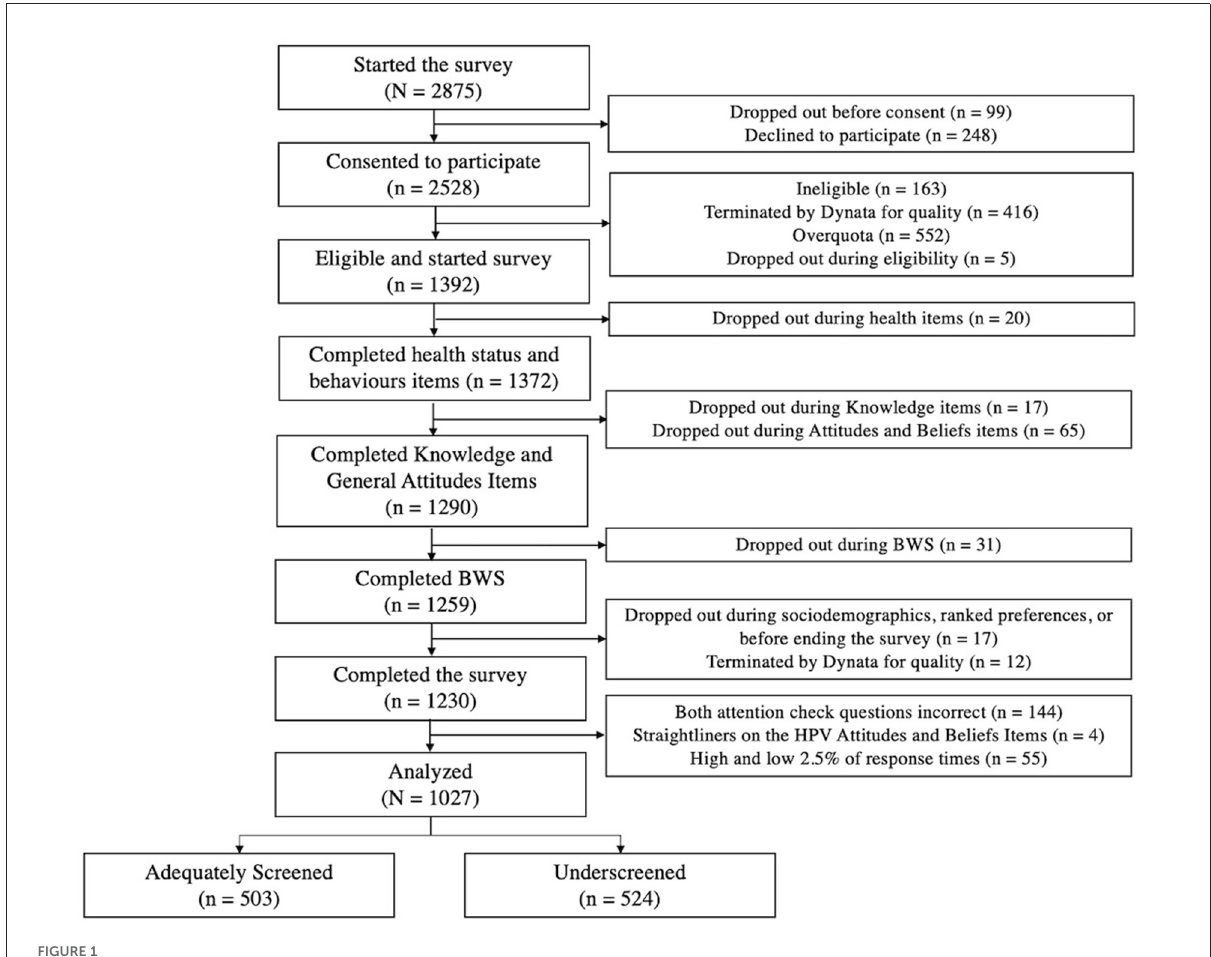
FIGURE1 Participant